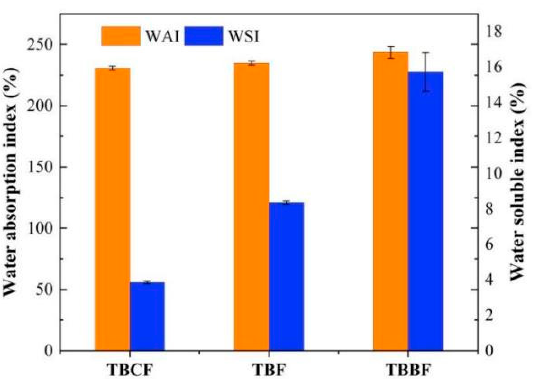
Figure 3. Water absorption index (WAI) and Water soluble index (WSI) of TBF, TBCF and TBBF (TBF: Tartary buckwheat flour; TBCF: Tartary buckwheat core flour; TBBF: Tartary buckwheat bran